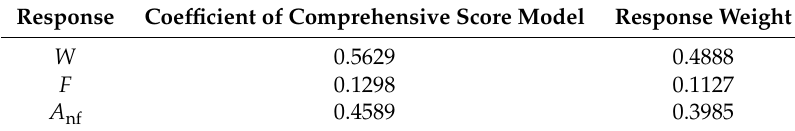
Table 10. Results of comprehensive score model coefficient and response